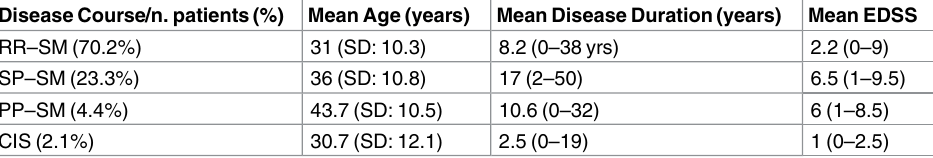
Table 1. Clinicalcharacteristicsby subcategories of diseasecourse. Disease Course/n. patients(%) Mean Age (years)